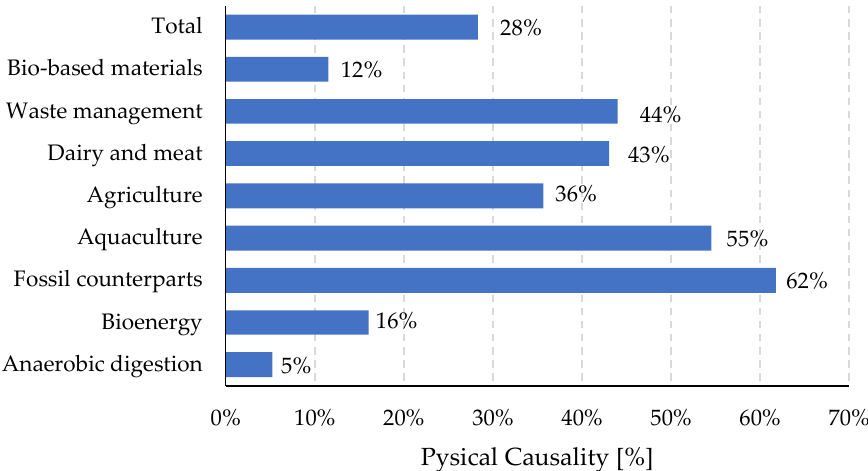
Figure 5. The percentage of studies in each research area that used causality as the principle for the allocation choices per (sub-)cluster and overall. The number of studies per sector: anaerobic digestion (21), bioenergy (185), fossil counterparts (34), agriculture (63), aquaculture (14), dairy and meat (79), waste management (50), bio-based materials (52).